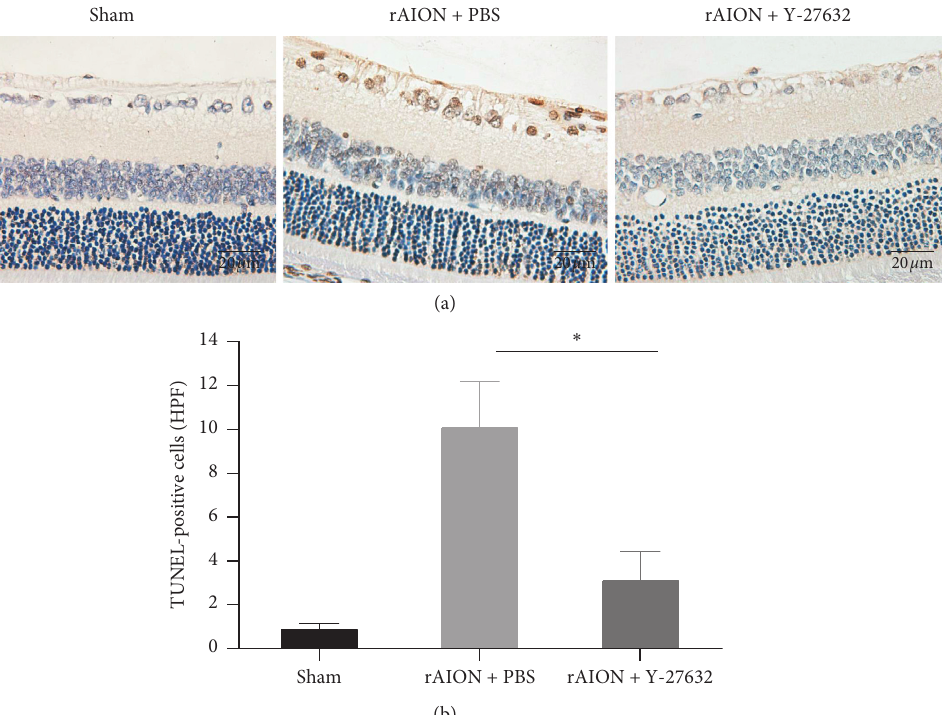
Figure 4: Analysis of RGC apoptosis at 28 days after induction as determined by TUNEL assay. (a) Representative TUNEL images showing apoptotic RGCs in brown; (b) quantification of the number of apoptotic RGCs in each group. The amount of apoptotic RGCs in the Y- 27632-treated group was significantly reduced compared with that in the PBS-treated group ( n � 6 per group). The asterisk indicates p < 0 . 05, as determined by the Kruskal–Wallis test. Scale bar: 20 μ